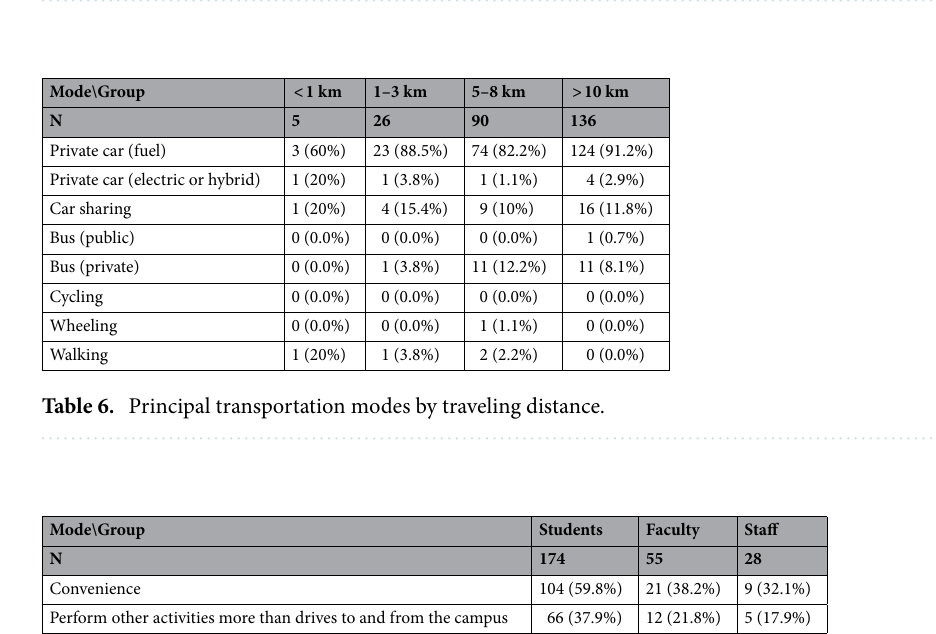
Table 5. Principal transportation modes by gender.